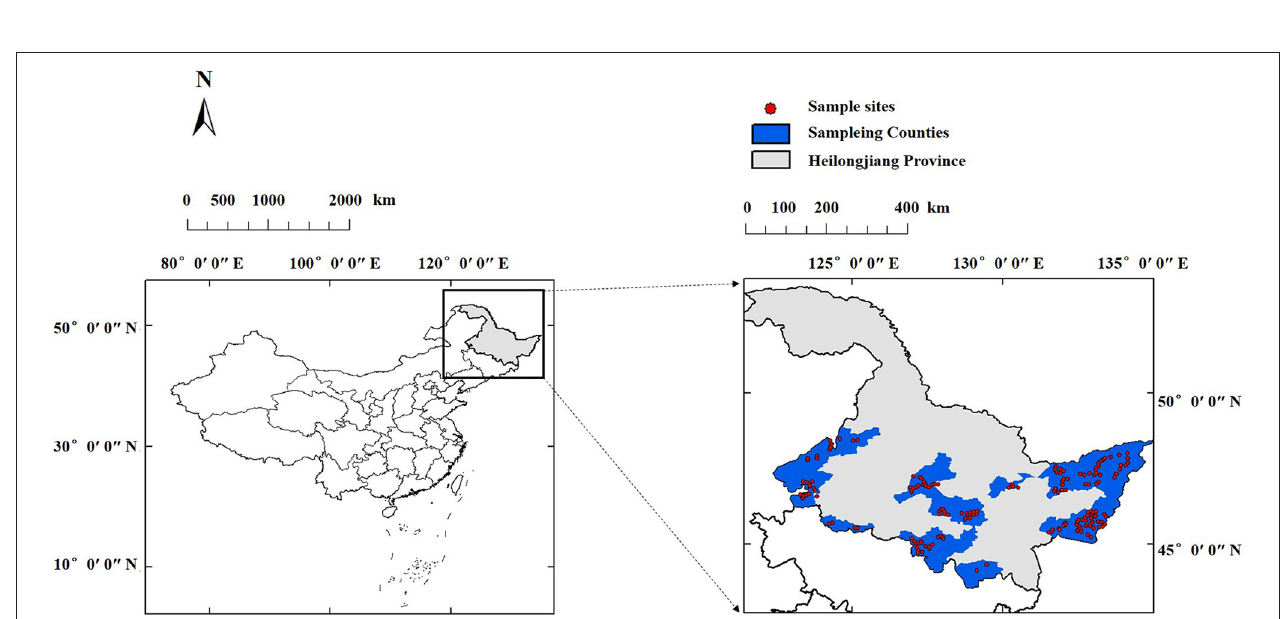
FIGURE 1 | Soil sampling locations in Heilongjiang Province, Northeast China. n =